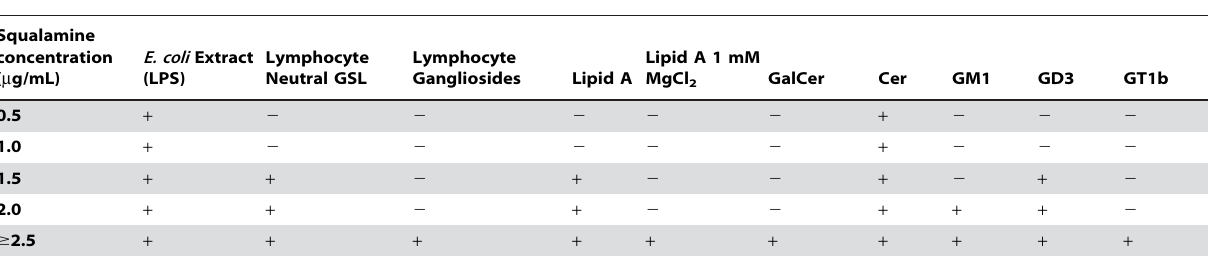
Table 5. Measurements of squalamine interactions with various bacterial and eukaryotic lipids.